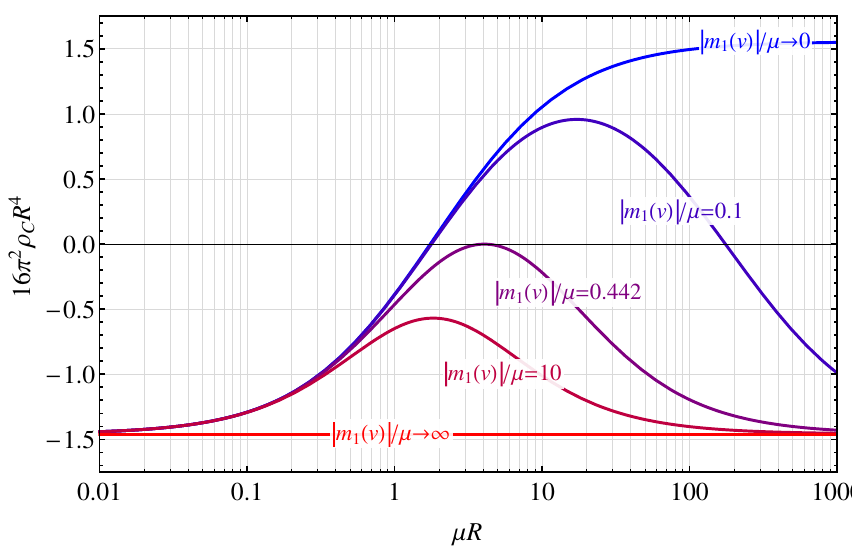
Figure 5 . Plots of the Casimir energy coe(cid:14)cient 16 (cid:25) 2 (cid:26) C R 4 as a function of the extra-dimensional radius R , in units of (the inverse of) the bulk-brane mixing scale (cid:22) . The (cid:12)ve curves are for (cid:12)xed (cid:22) but m 1 ( v ) variable , increasing from top (blue) to bottom (red). The Casimir energy can be j j